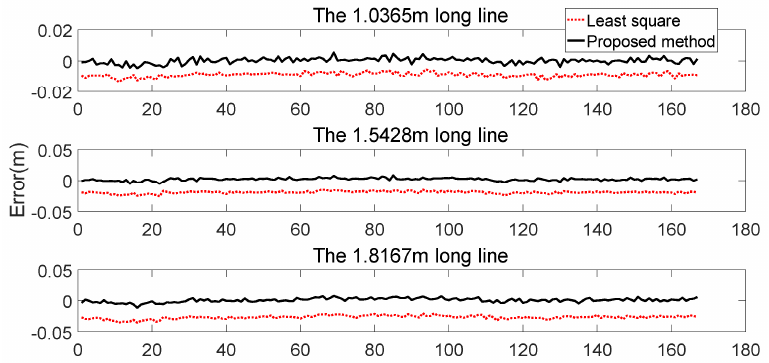
Figure 18. Errors of the traditional least square and proposed methods using NAV350 as ground truth. It can be seen that the error of the proposed method is always less than that of the traditional least square.